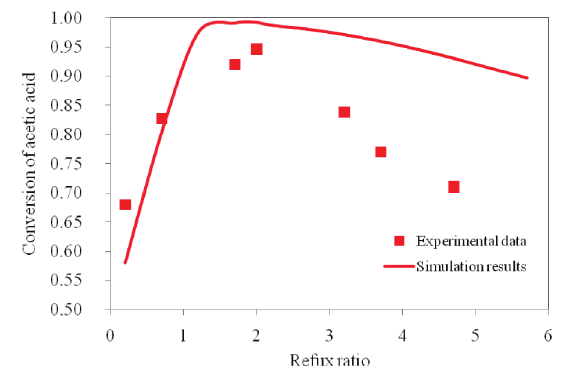
Fig. 7 – Conversion of acetic acid versus reflux ratio. Solid line represents the simulation results from equilibrium stage model, and symbols represent the experimental